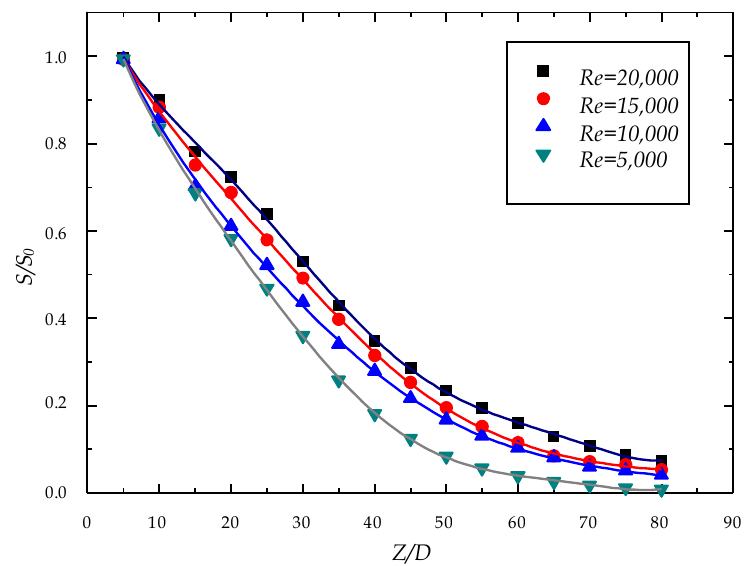
Figure 14. When Y = 6.2, the number of dimensionless swirl varies with the position at different Reynolds numbers.